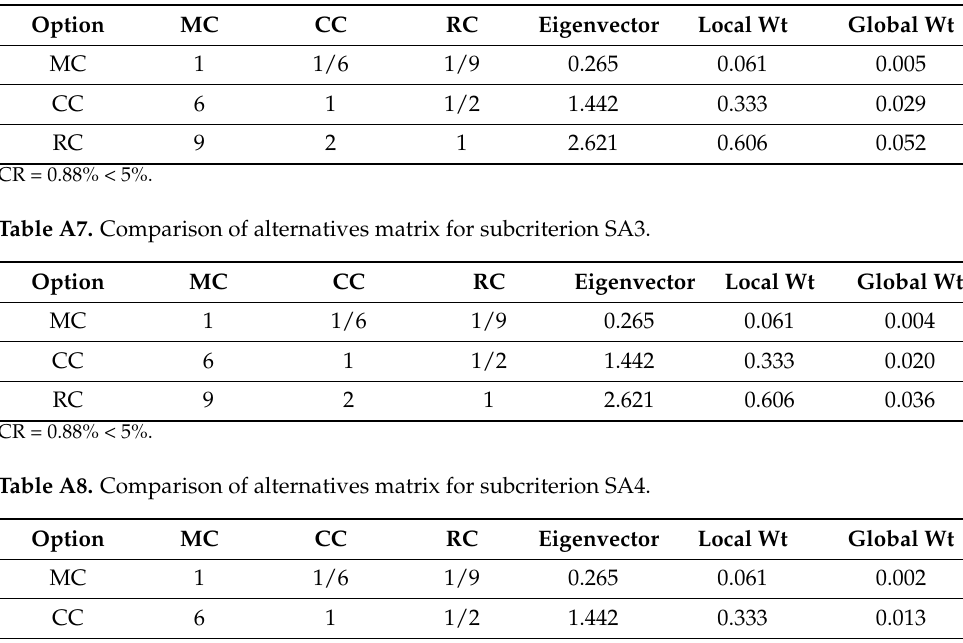
Table A6. Comparison of alternatives matrix for subcriterion SA2.